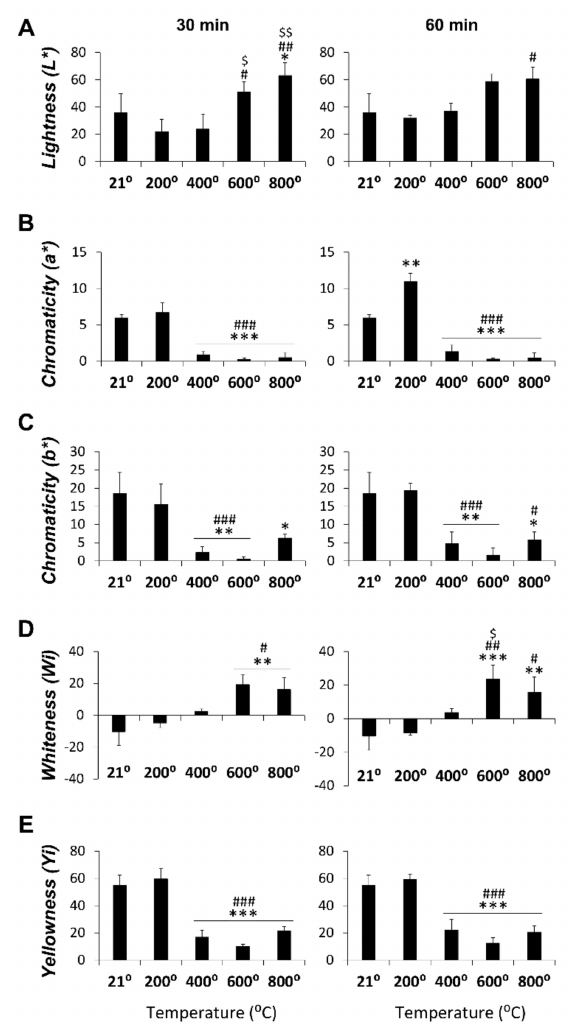
Figure 4. Spectrophotometric color measurements in the medullar bone zone (L*, a*, b*, WI, and YI) in the control and those heated at 200, 400, 600, and 800 °C for 30 and 60 min. ( A ): Lightness parameter for 30 and 60 min; ( B ): Chromaticity a* parameter for 30 and 60 min; ( C ): Chromaticity b* parameter for 30 and 60 min; ( D ): Whiteness parameter for 30 and 60 min and ( E ): Yellowness parameter for 30 and 60 min. histograms represent means ± SEM ( n = 4). ANOVA: * / ** / *** p < 0.05 / 0.01 / 0.001 vs. control group, # / ## / ### p < 0.05 / 0.01 / 0.001 vs. 200 °C, $ / $$ p < 0.05 / 0.01 vs. 400